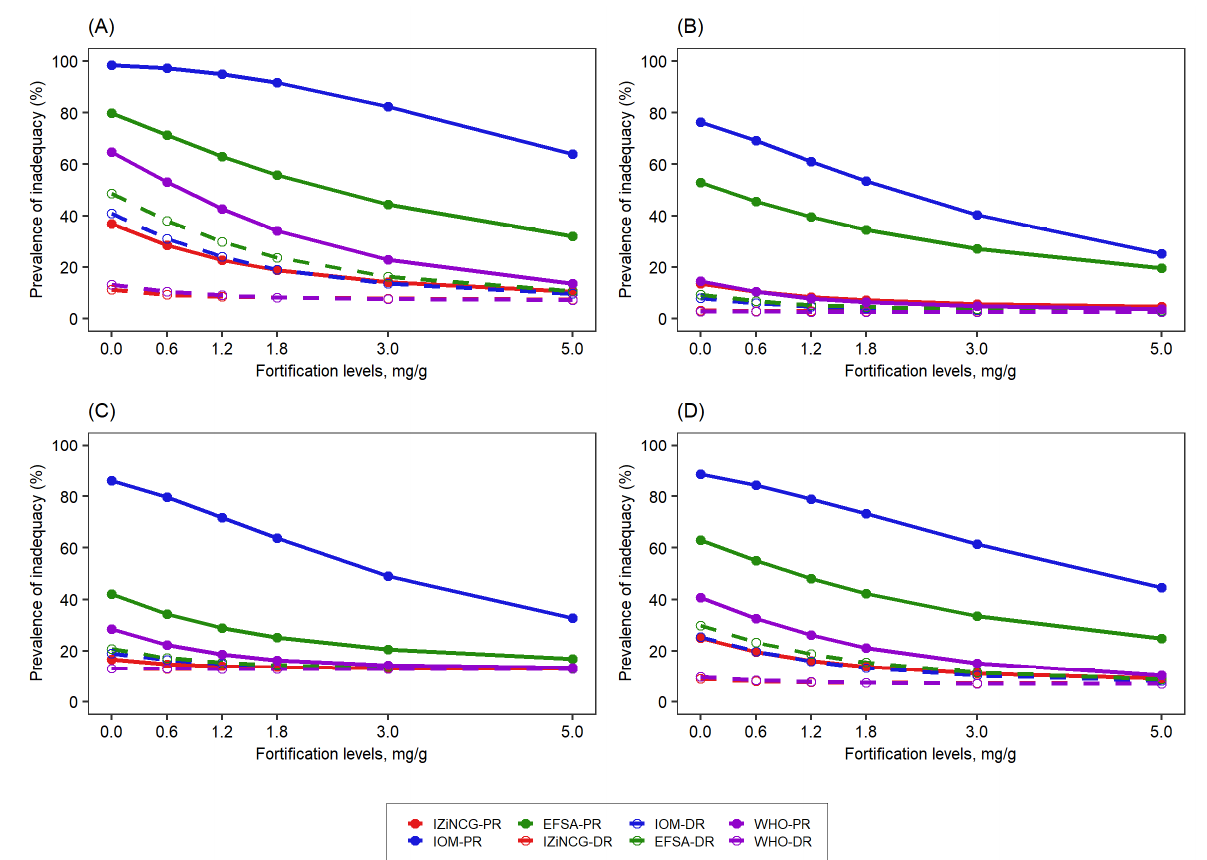
Figure 6. Effect of the level of zinc fortification of bouillon cube (mg zinc/g bouillon cube) on the prevalence of inadequate intake among women in the presence of a wheat flour fortification (95 mg zinc/kg flour) according to different NRVs. ( A ) South-macro region, ( B ) North macro-region, ( C ) Yaound é